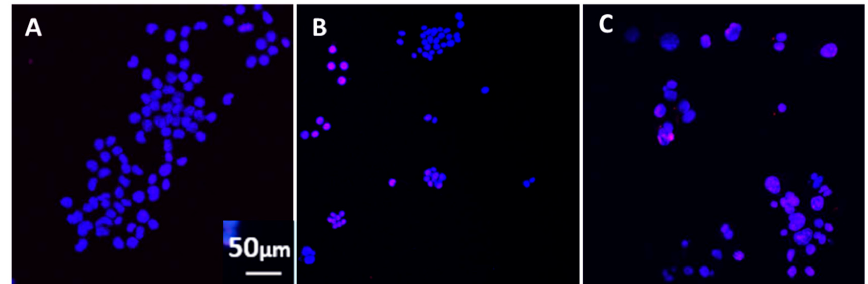
Figure 2. ( A ) Control (blue, 4 ′ ,6 ‐ diamidino ‐ 2 ‐ phenylindole (DAPI)) staining of N2A cell nuclei indicates healthy cells. The cells were cultured in the absence ( A ) or presence ( B ) of influenza vaccine or ( C ) S. Typhi vaccine for two days. Red ‐ stained, terminal deoxynucleotidyl transferase ‐ mediated dUTP nick end labeling (TUNEL) nuclei indicate DNA breaks and, hence, apoptotic cells. DAPI (blue) ‐ stained nuclei represent nuclei of healthy cells.